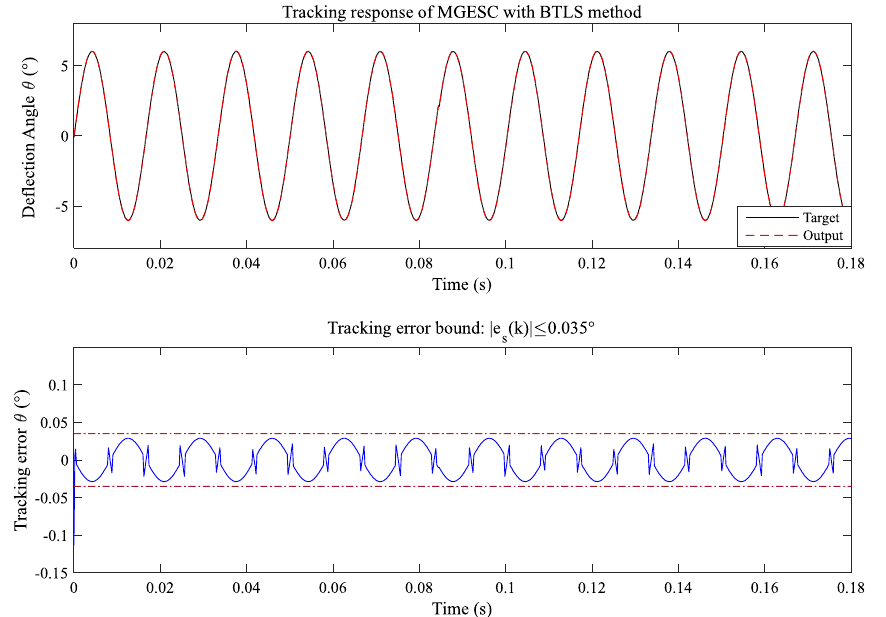
Figure 17. Tracking performance of the MGESC with BTLS method.